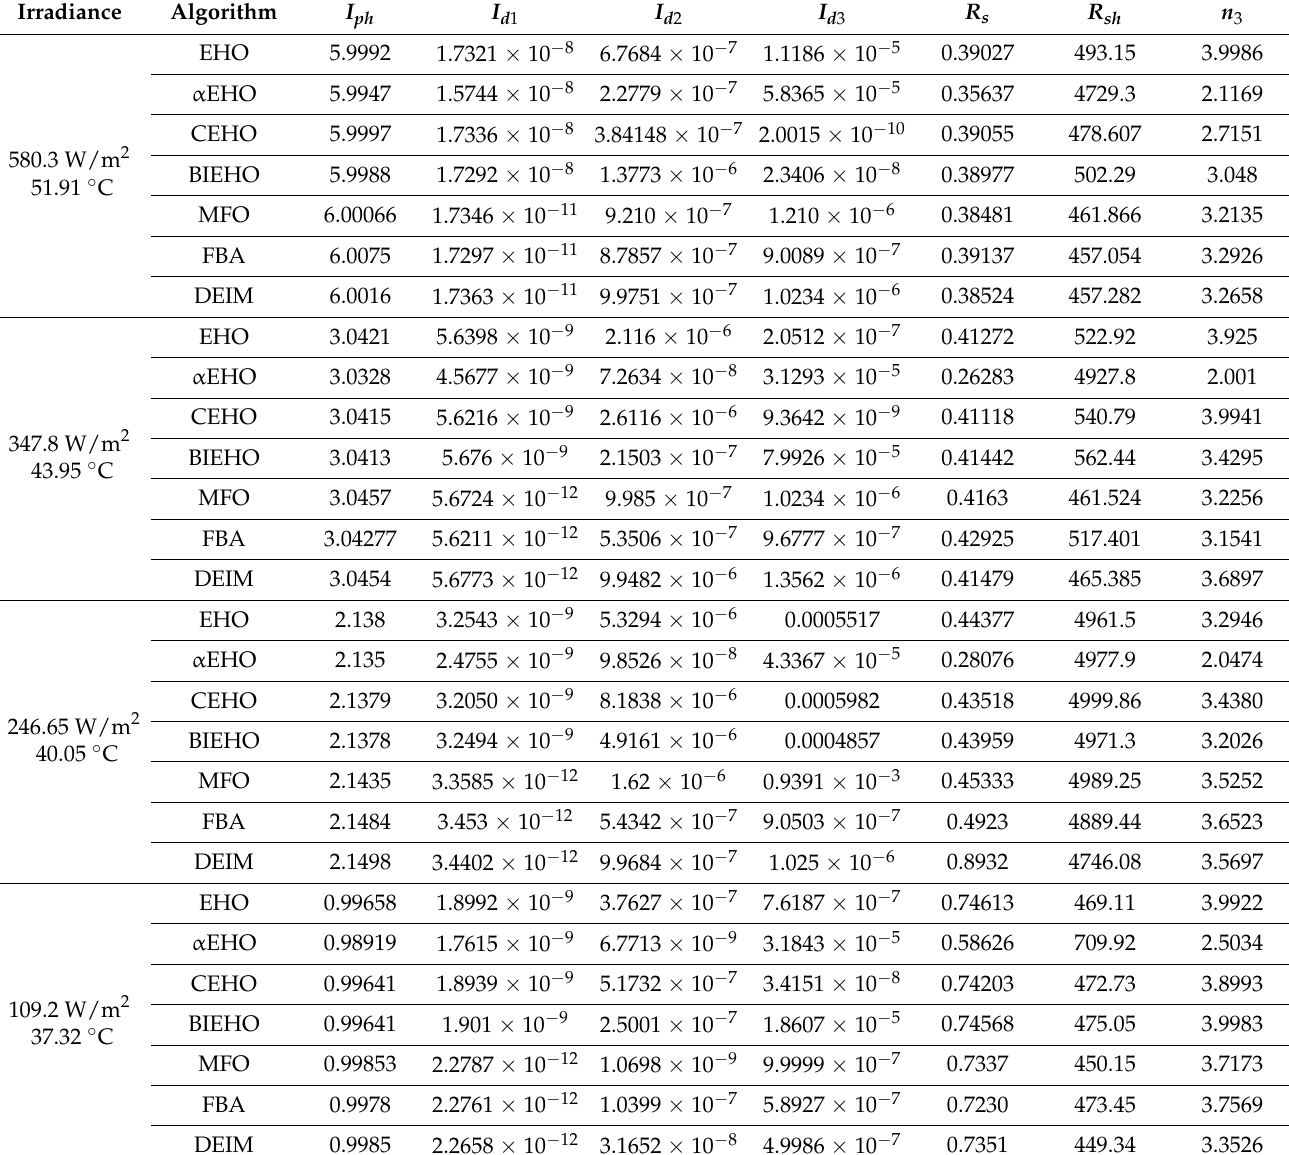
Table 7. Comparison between different EHO algorithms among irradiance levels.